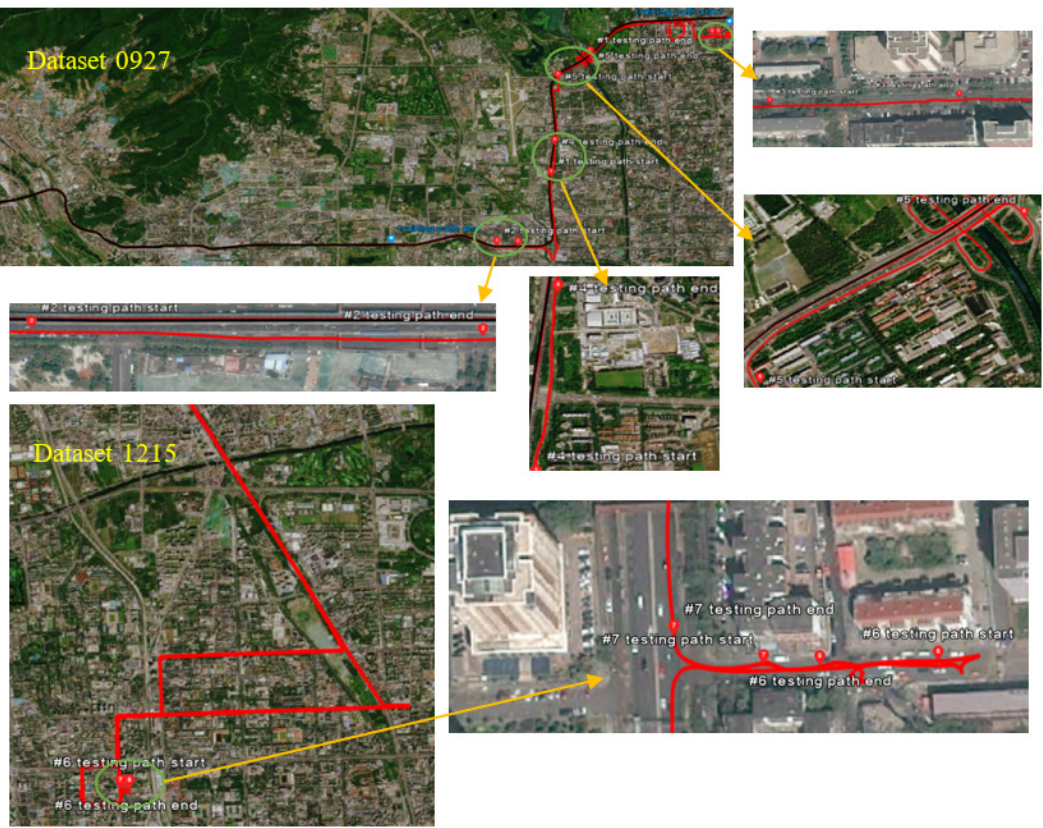
Figure 6. The trajectory of the road experiment in dataset 0927 and dataset 1215.